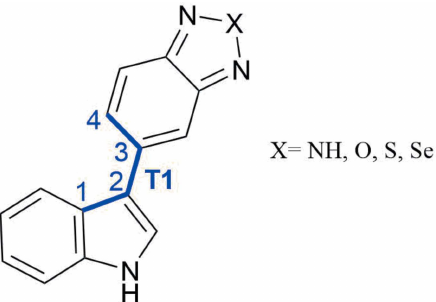
Figure 1 Structures of bioisosteres of 5-(1 H -indol-3-yl)-benzotriazole with their torsion angle. X = NH, O, S,